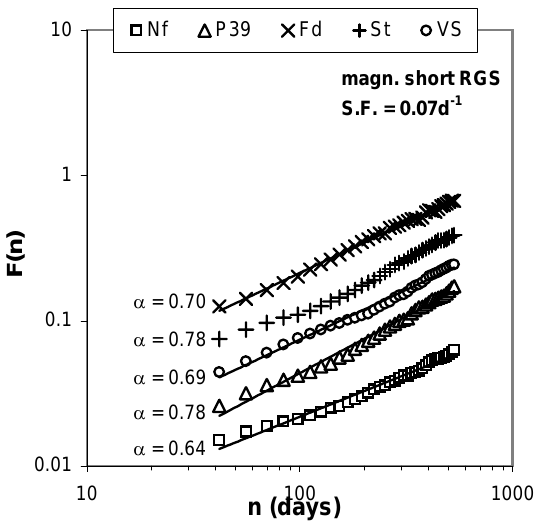
Fig. 13. Log-log plot of F(n) vs. n , for the magnitude RGS from St, Fd and shortened VS, Nf and P39 signals. The F(n) functions Figure 13 . Log-log plot of F ( n ) vs. n , for the magnitude RGS from St, Fd and shortened VS, Nf and of the sites have been shifted for clarity. P39 signals. The F ( n ) functions of the sites have been shifted for clarity.